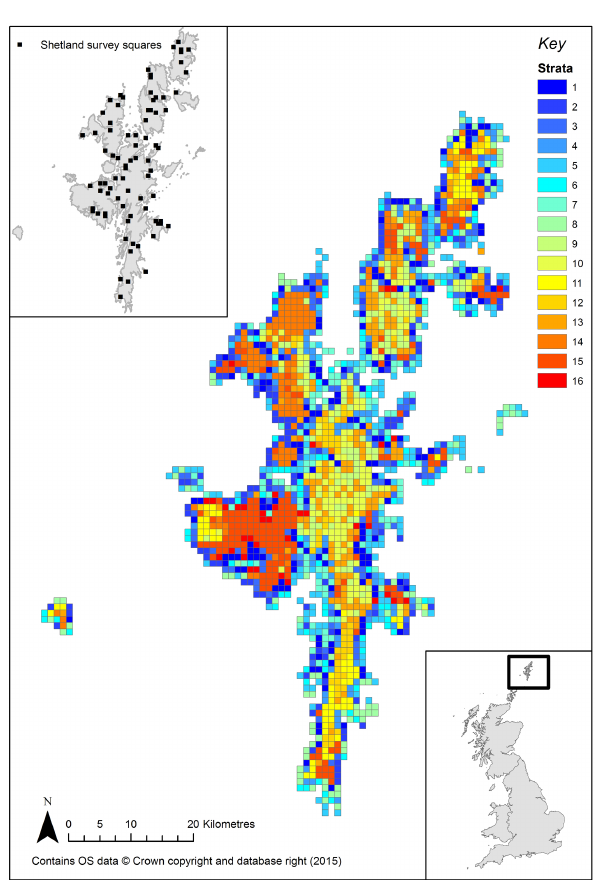
Figure 2. Map of sampling sites and